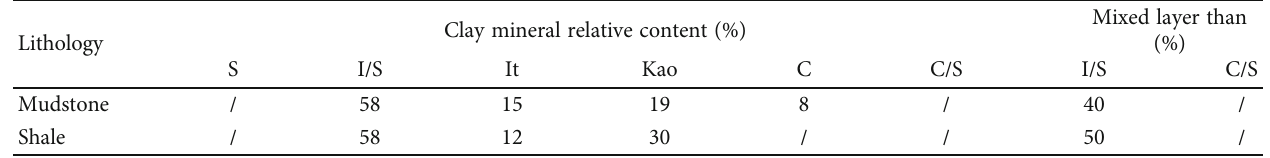
Table 4: Clay mineral relative content of the surrounding